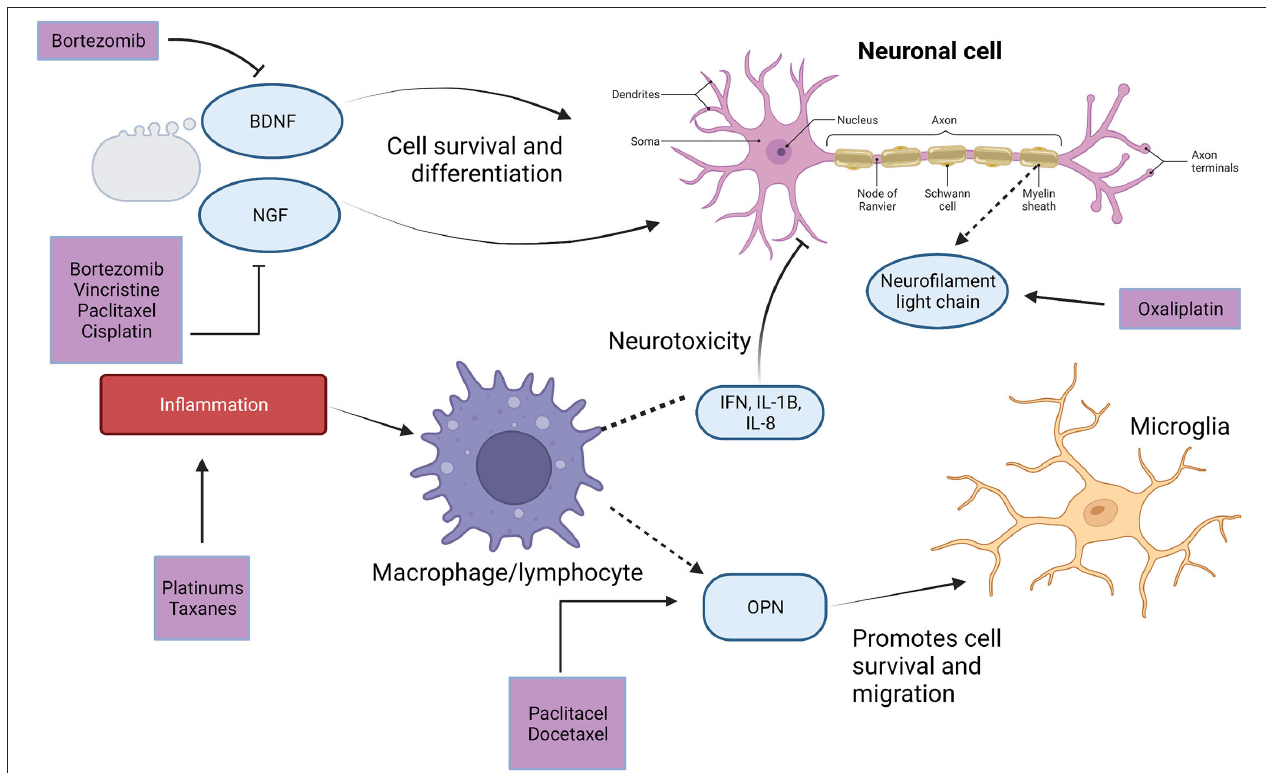
FIGURE 1 | Serum markers of CIPN and their role in CIPN pathogenesis. Adapted from “Neuron Anatomy,” by BioRender.com (2022). Retrieved from https://app. Biorender.com/biorender-templates. CIPN, chemotherapy-induced peripheral neuropathy; BDNF, brain derived neurotrophic factor; NGF, nerve growth factor; OPN,